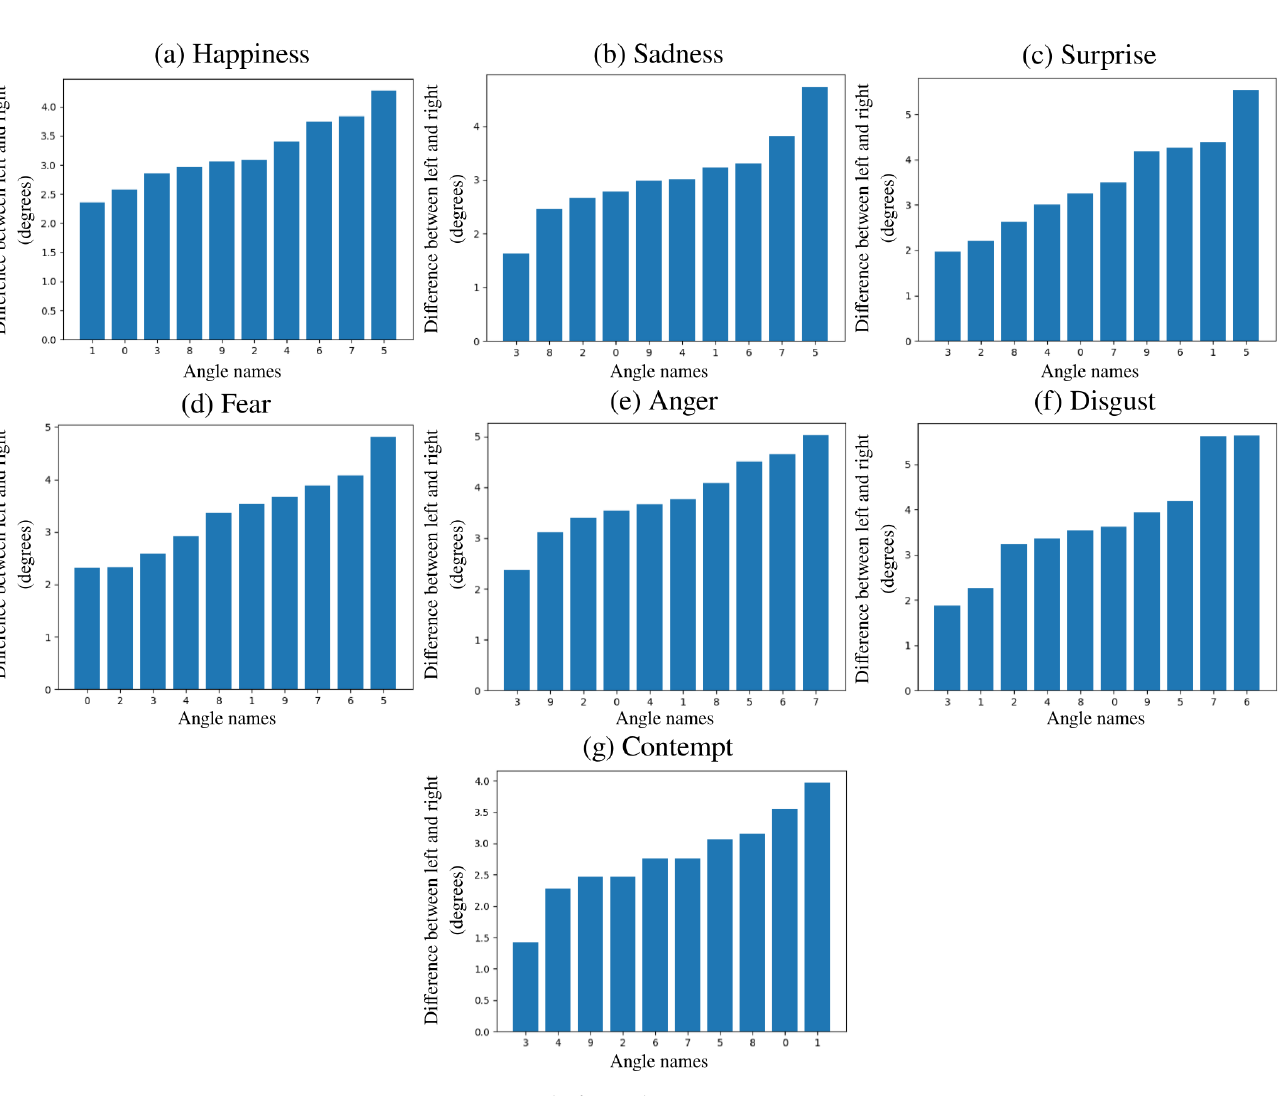
Figure 9. Symmetry study for each emotion.